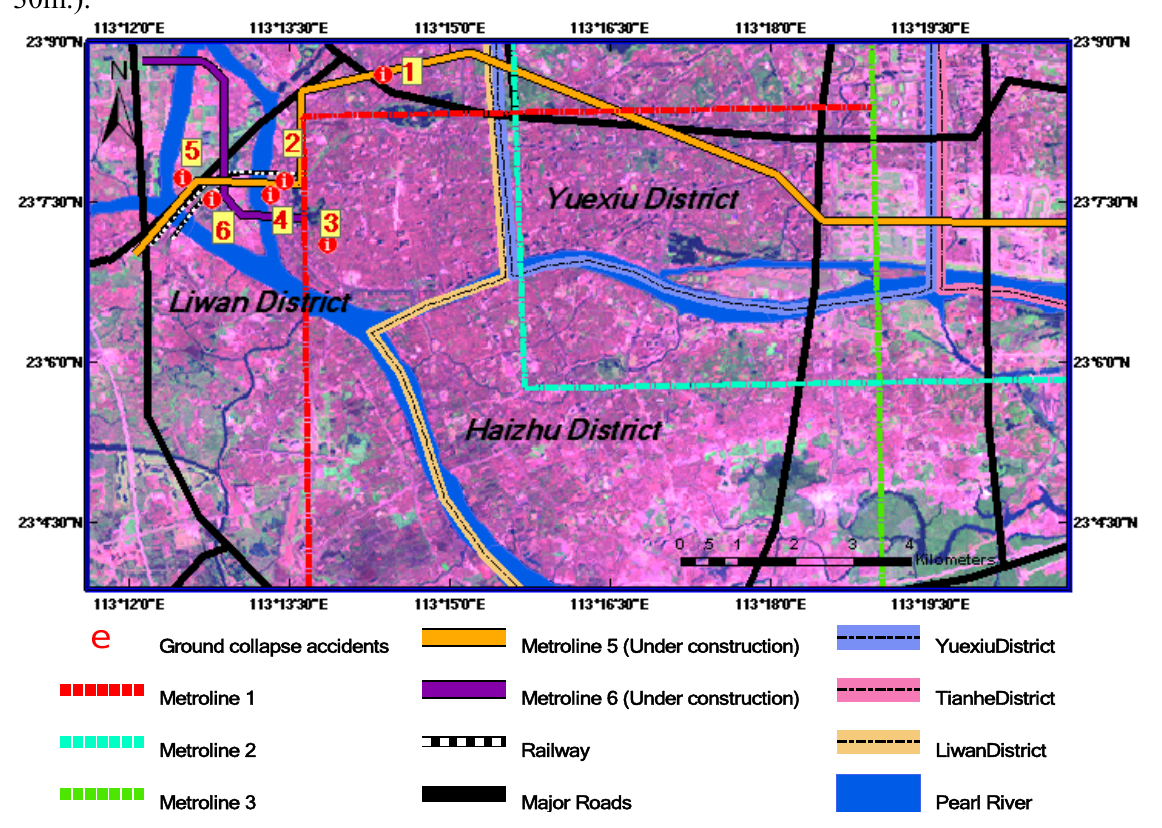
Figure 3. The spatial distribution of ground collapse accidents in 2007–2008 are coded from 1 to 6. The underground metro-lines and district boundary lines are also marked. (The background image is Landsat TM false color composite image. The spatial resolution is 30m.).